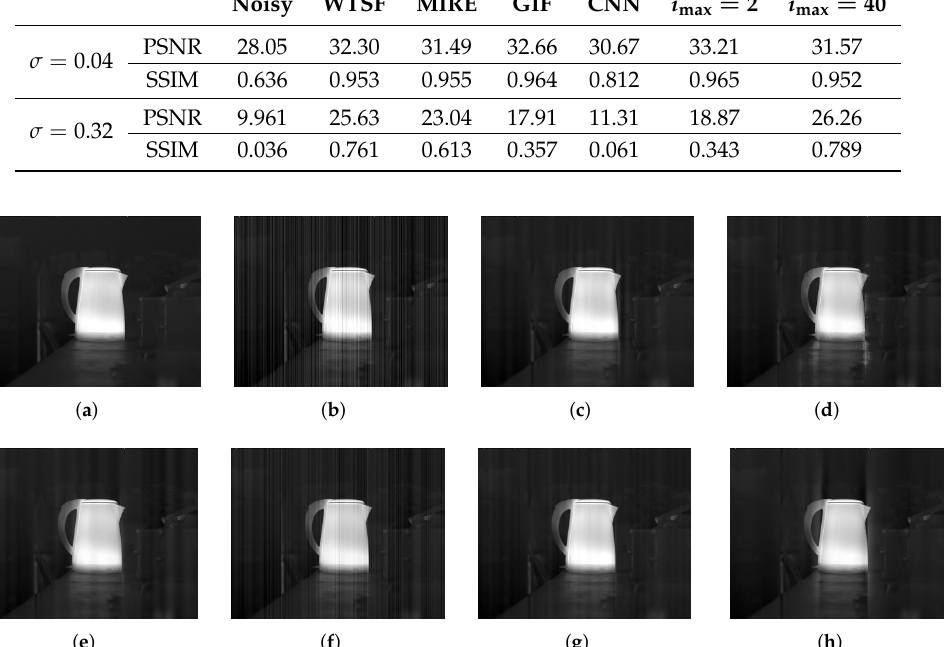
Table 6. PSNR (dB) and SSIM results for Kettle corrupted by stripe noise with σ = 0.04 and σ = 0.32. Noisy